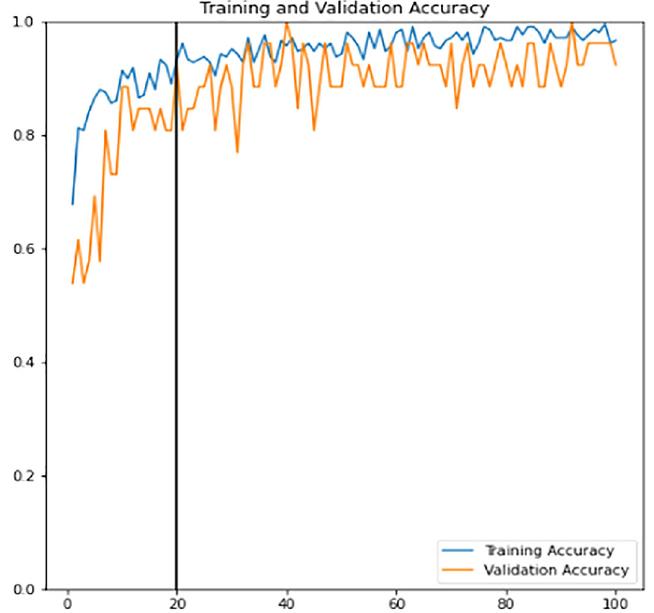
Figure 12. Training learning curve of accuracy for training and validation sets of the fine-tuned classifier.